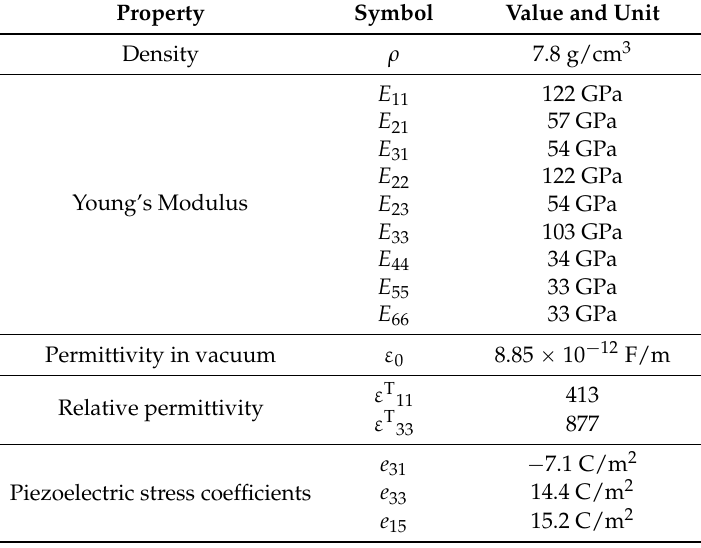
Table A2. Material parameters of the PIC181 calculated on the basis of the manufacturer data